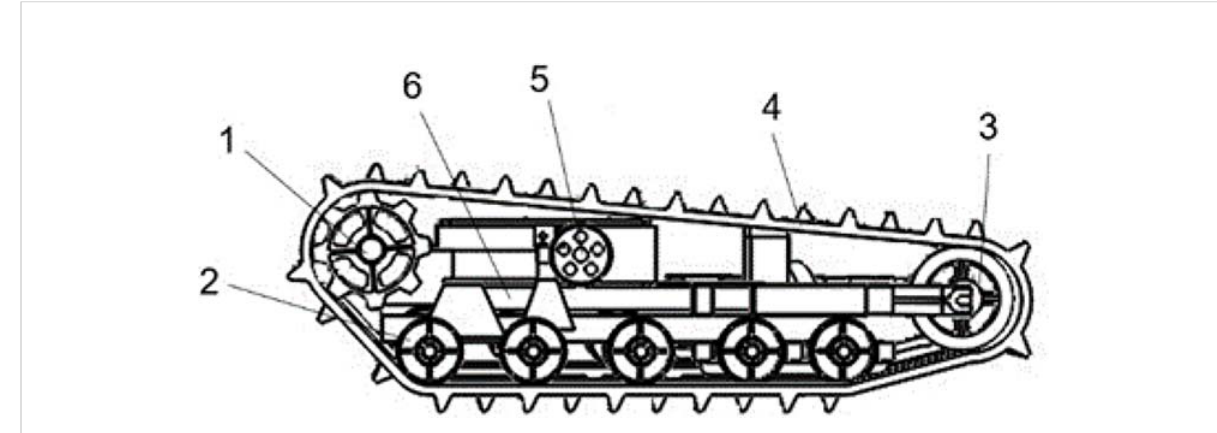
FIGURE 3 Crawler mobile chassis. 1. Track drive wheels; 2. Support weight running wheels; 3. Guide wheels; 4. Rubber tracks; 5. Carrier wheels; 6. Track tensioning mechanism.